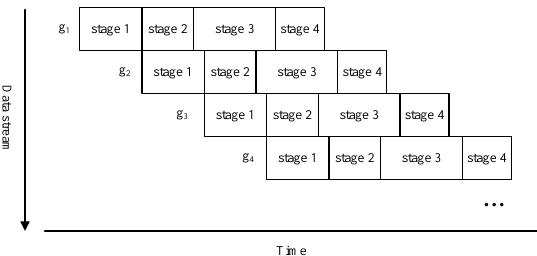
Figure 6. Illustrating the communication scheme of the four-stage